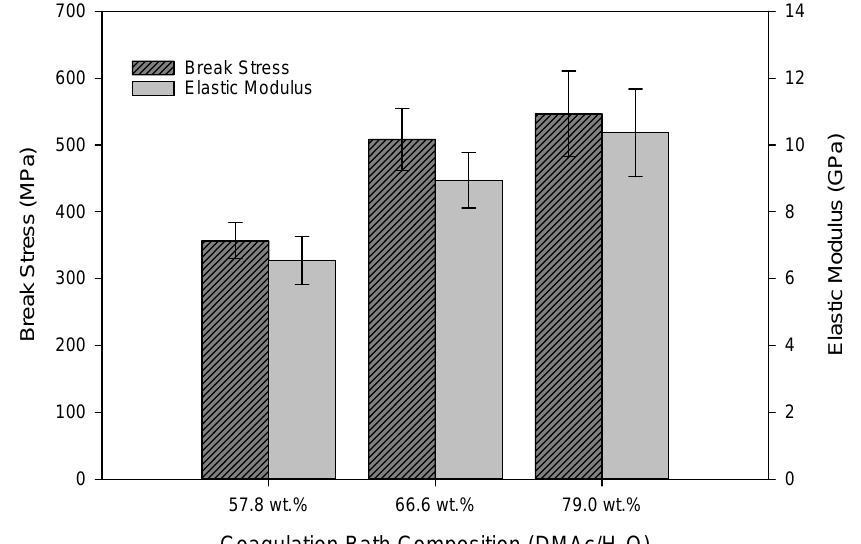
Figure 11. Tensile properties of as-spun fiber (sampling point IV) ( N ≥ 20 for each bath